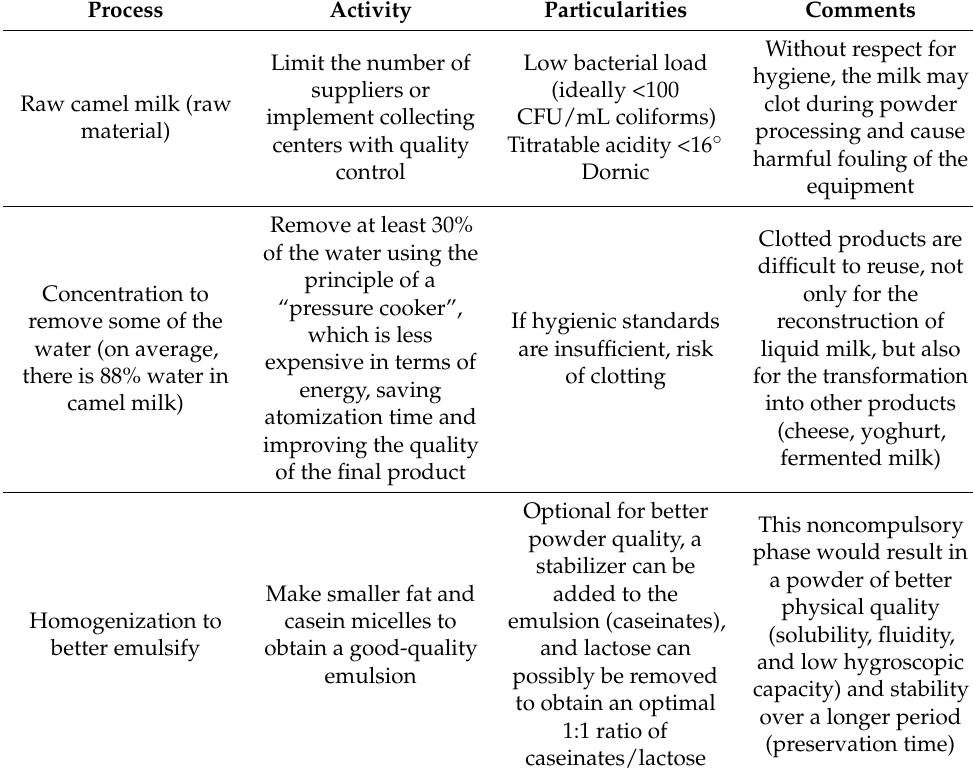
Table 3. Possible improvements to obtain camel milk powder with high